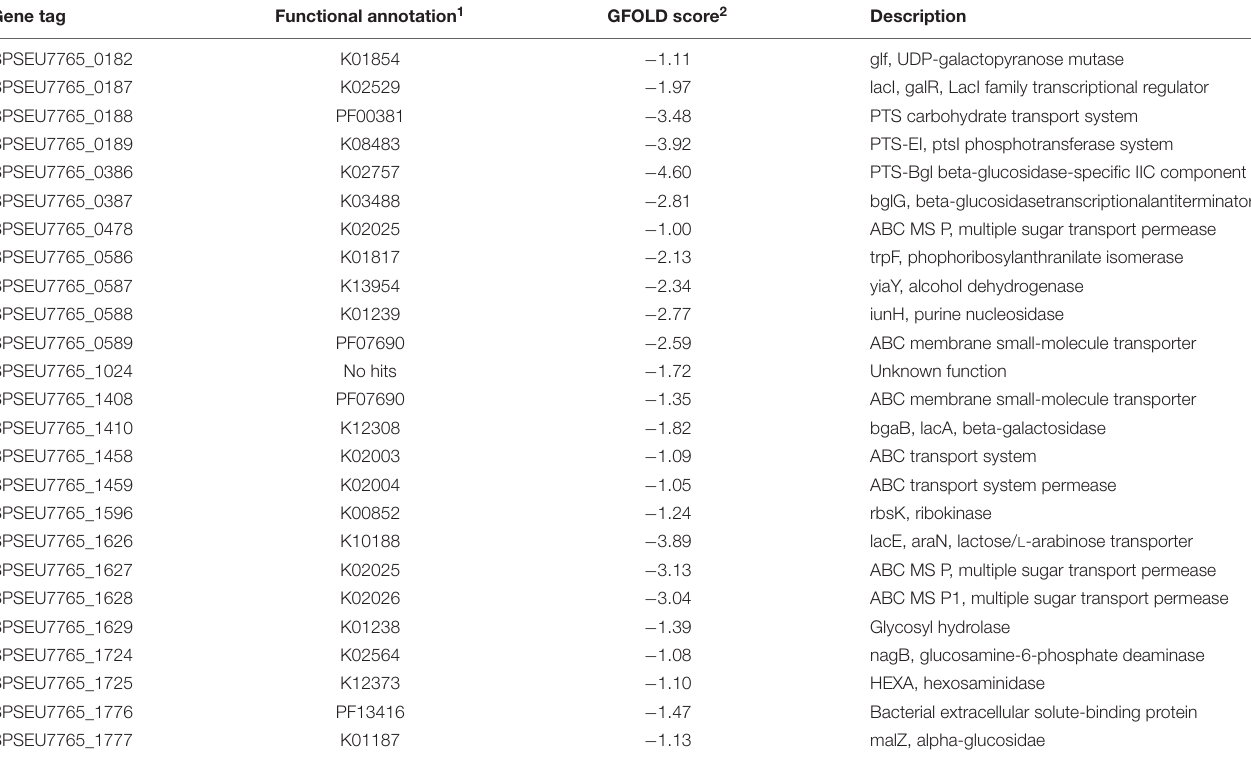
TABLE 3 | List of B. pseudocatenulatum CECT 7765 down-regulated genes during GOS-Lu